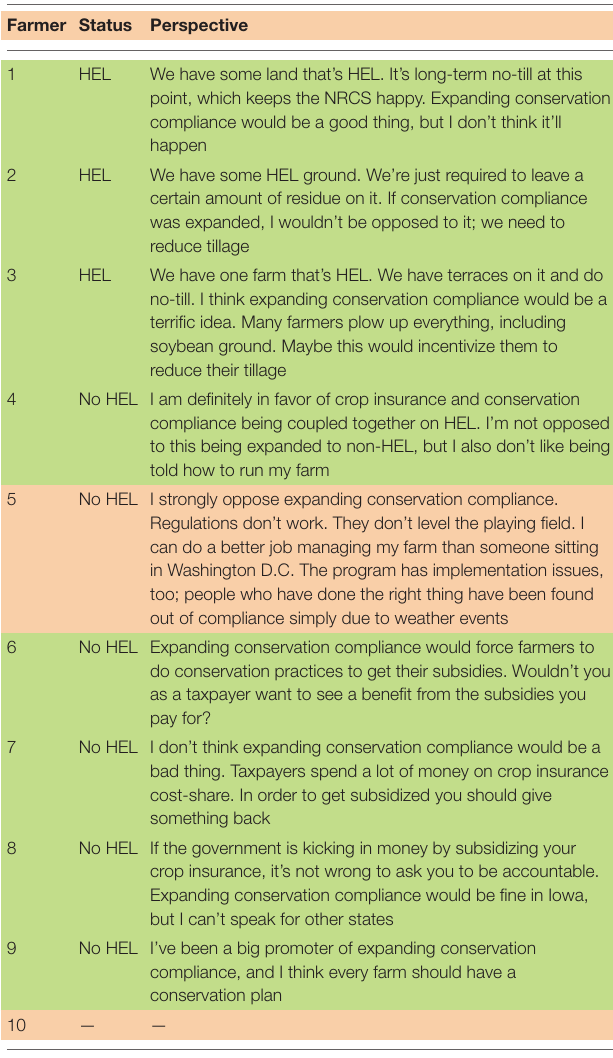
TABLE 3 | Farm environmental leaders’ perspectives on the expansion of conservation compliance (favorable views in light green). Farmer Status